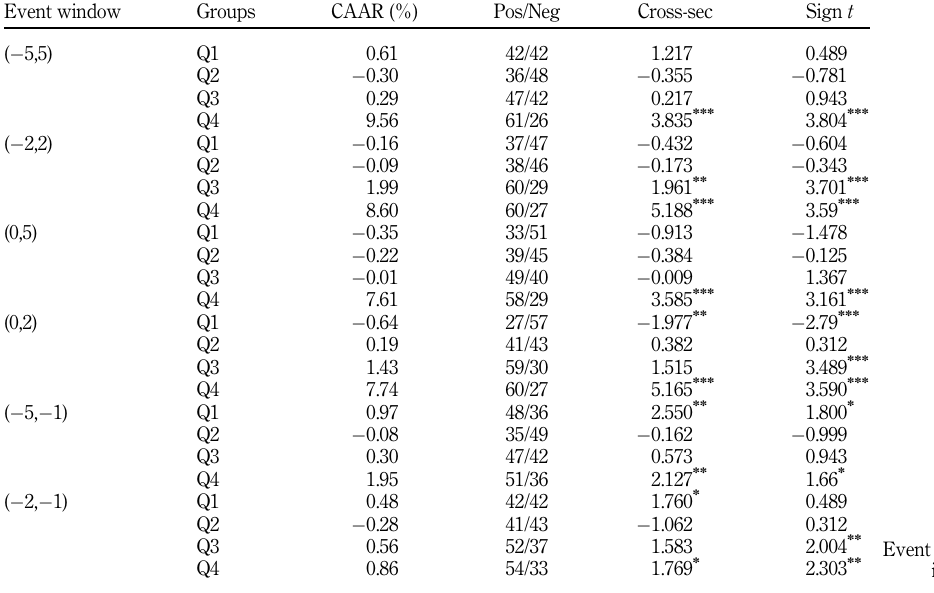
Table 7. Event study results